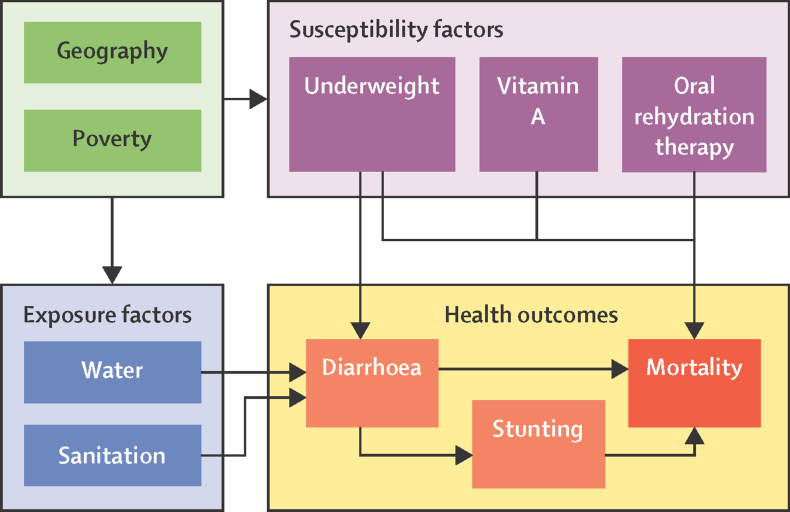
Conceptual framework of the diarrhoeal mortality risk model